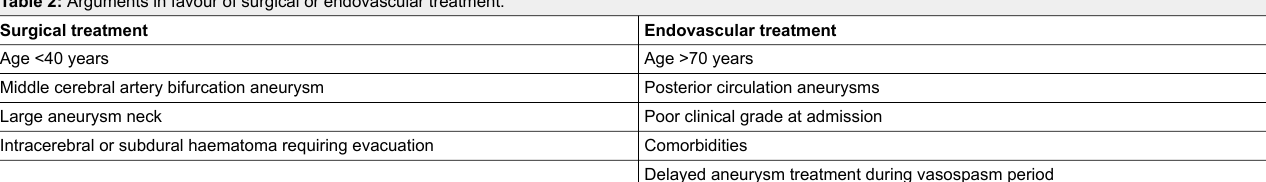
Table 2: Arguments in favour of surgical or endovascular